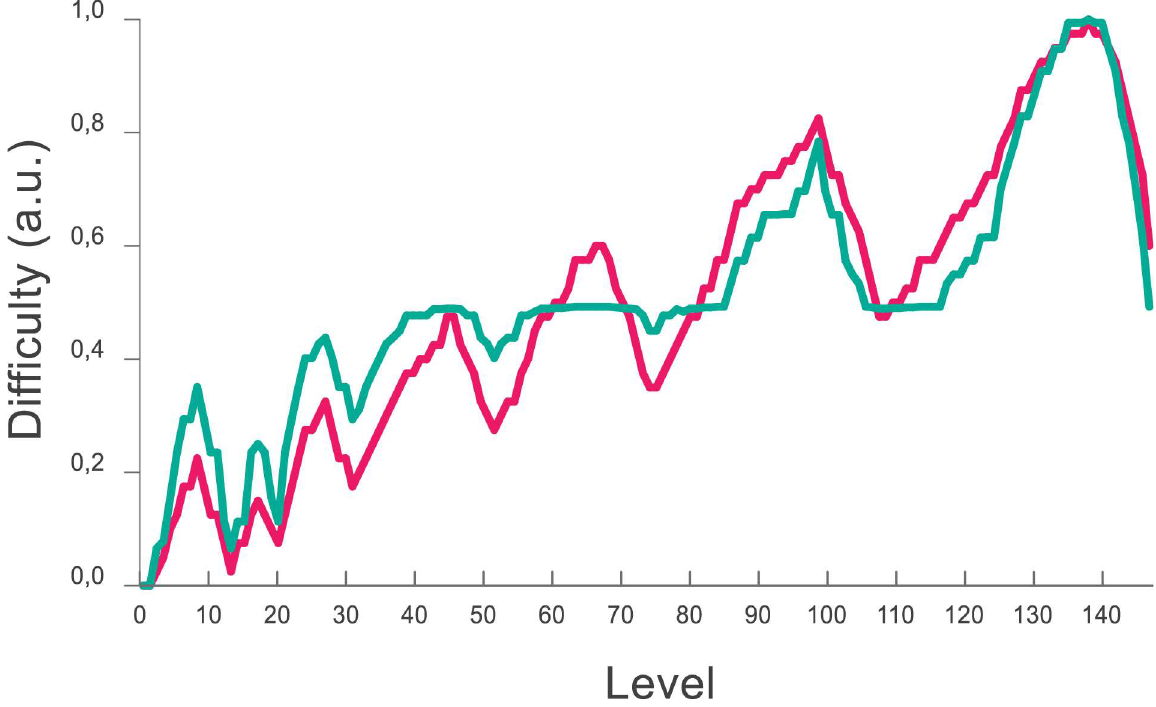
Fig 2. Difficulty as a function of the level. To generate an engagingexperience, difficulty progressesas a series of increasesand decreases. The difficulty in each level is shownaccordingto a prediction based on the numberof mental computations and memory load requiredby each problem (magenta). This correlatesas expectedwith the measuredRTs (green)after the